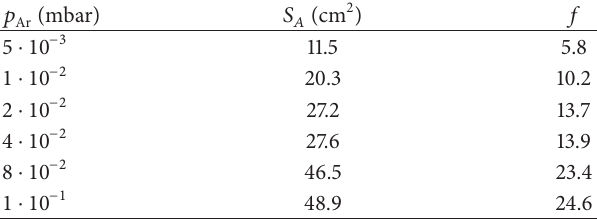
Table 3: Electrochemically active surface ( 𝑆 𝐴 ) and roughness factor ( 𝑓 ) of Pd films deposited at various 𝑝 voltammeter